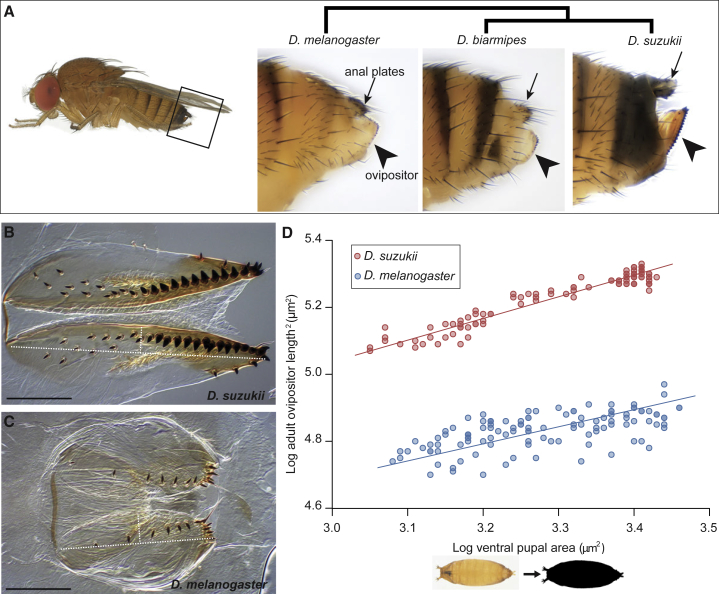
Evolutionary Shift in the Scaling Relationship of Ovipositor Length against Body Size between D. suzukii and D. melanogaster(A) Adult ovipositors of 3 closely related Drosophila species, D. melanogaster, D. biarmipes, and D. suzukii, in lateral profile (arrowhead indicates ovipositor, arrow indicates anal plates). The D. suzukii female is on the left; the boxed area indicates the approximate posterior region shown in the panels. Images are reproduced from [9].(B and C) D. suzukii and D. melanogaster adult ovipositors, respectively. The long, white, dashed line indicates the measured length; the short indicates half width. The scale bar represents 200 μm.(D) Scaling relationship of ovipositor length squared and body size in D. melanogaster (blue; n = 114) and D. suzukii (red; n = 99) on a log-log scale. The overall body size is measured using ventral pupal area as a proxy, as illustrated on the x axis. The slope is modestly steeper in D. suzukii, increasing by 27% (D. melanogaster slope = 0.51, 95% CI = 0.44–0.59; D. suzukii slope = 0.65, 95% CI = 0.61–0.69; common slope test, p < 0.01). But more importantly, the intercept is shifted upward, indicating that ovipositor length is enlarged across the full range of body sizes.See also Data S1.